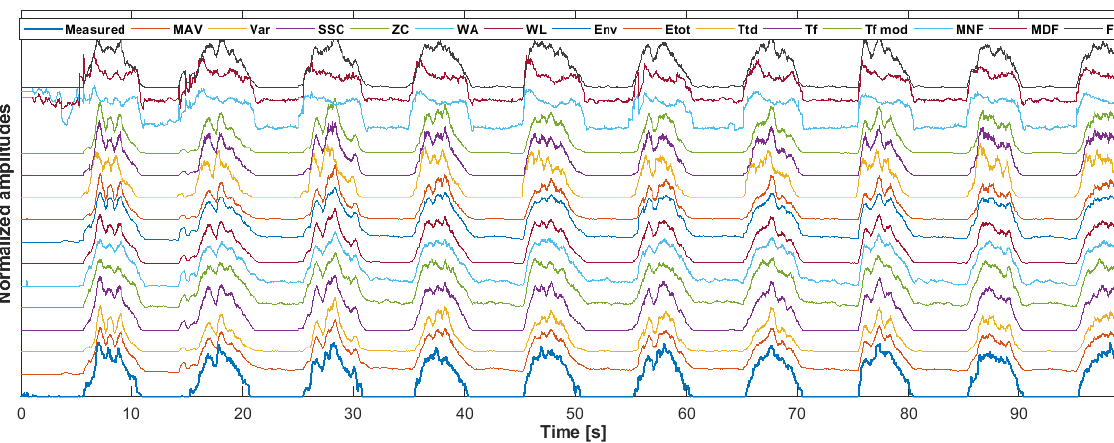
Figure 3. Measured force (blue—bottom row) and estimated forces using different algorithms. Each algorithm output (and the force signal) was normalized using the maximal amplitude within the first two repetitions as the scaling factor. The example signals are based on subject 15, EDC muscle and ring finger extension.